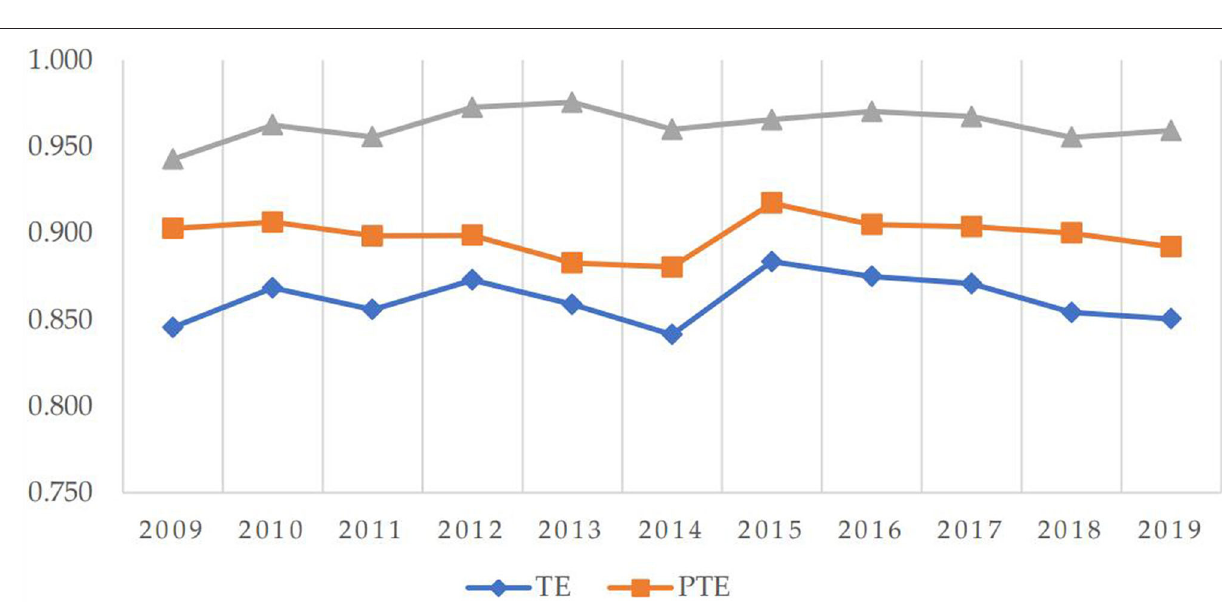
FIGURE 2 | Breakdown of health production efficiency from 2009 to